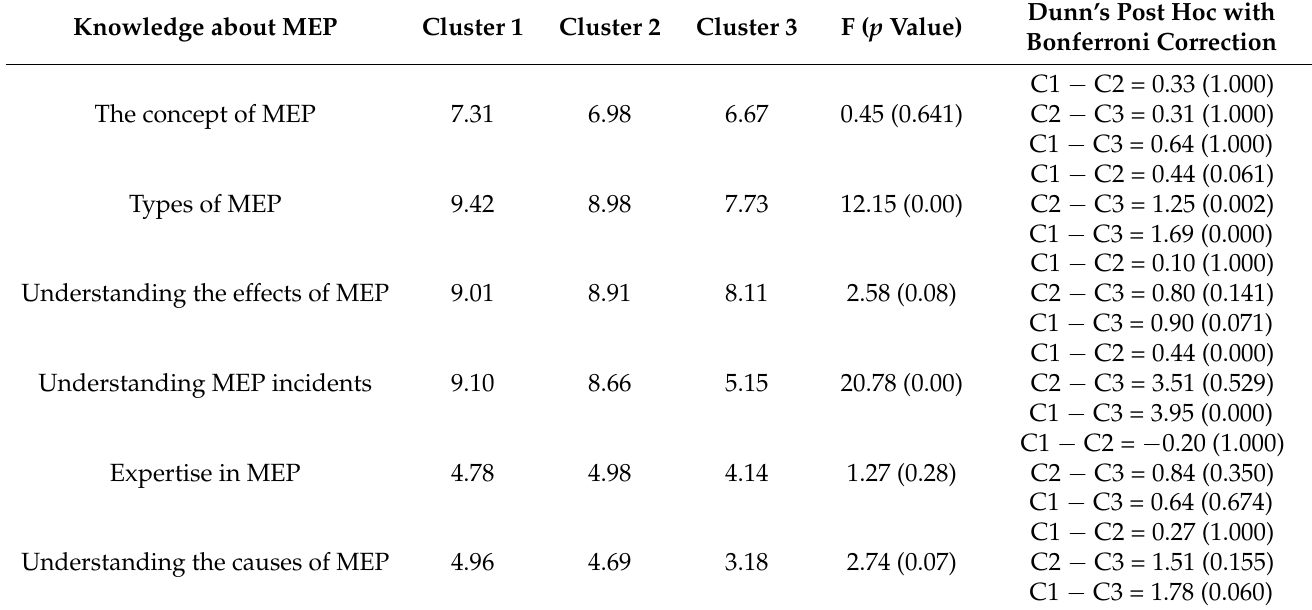
Table 4. Attitudes toward marine environment pollution (MEP) and related knowledge